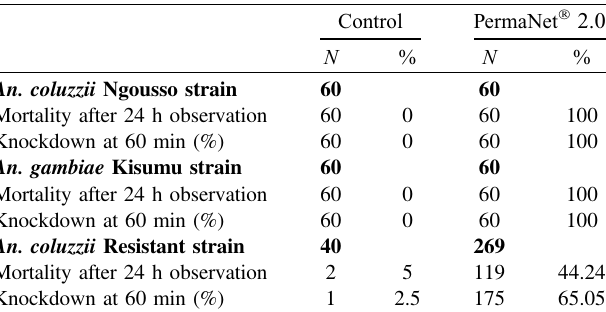
Table 3. Knockdown and mortality of different Anopheles gambiae s.l. colonies used for cone bioassays.